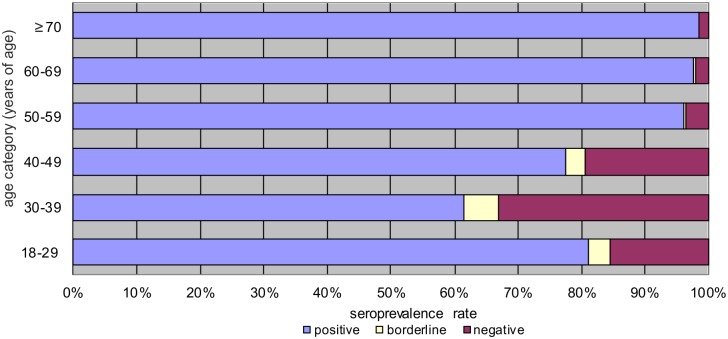
Prevalence of IgG antibodies against measles by age group.